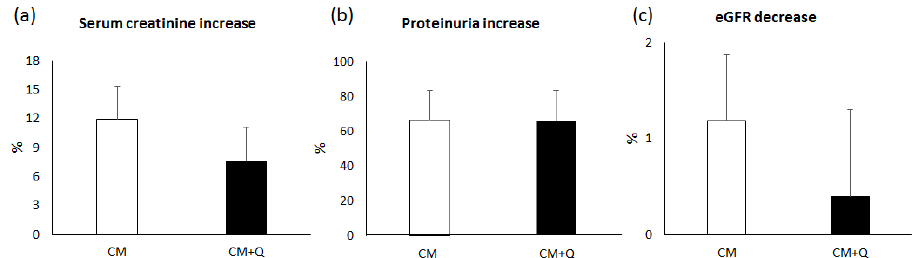
Figure 2. Renal function assessment in each study group. CM, patients who were administered iodinated contrast media; CM+Q, patients receiving iodinated contrast media and quercetin. ( a ) Increase in serum creatinine; ( b ) Increase in proteinuria; ( c ) Decrease in eGFR calculated using the Chronic Kidney Disease Epidemiology Collaboration (CKD-EPI) formula. Increases or decreases were calculated as % using basal biomarker data and the highest value observed during the 72 h after contrast media administration. Data are expressed as mean ± standard error of the mean. No significant differences were found ( p > 0.05). eGFR, estimated glomerular filtration rate